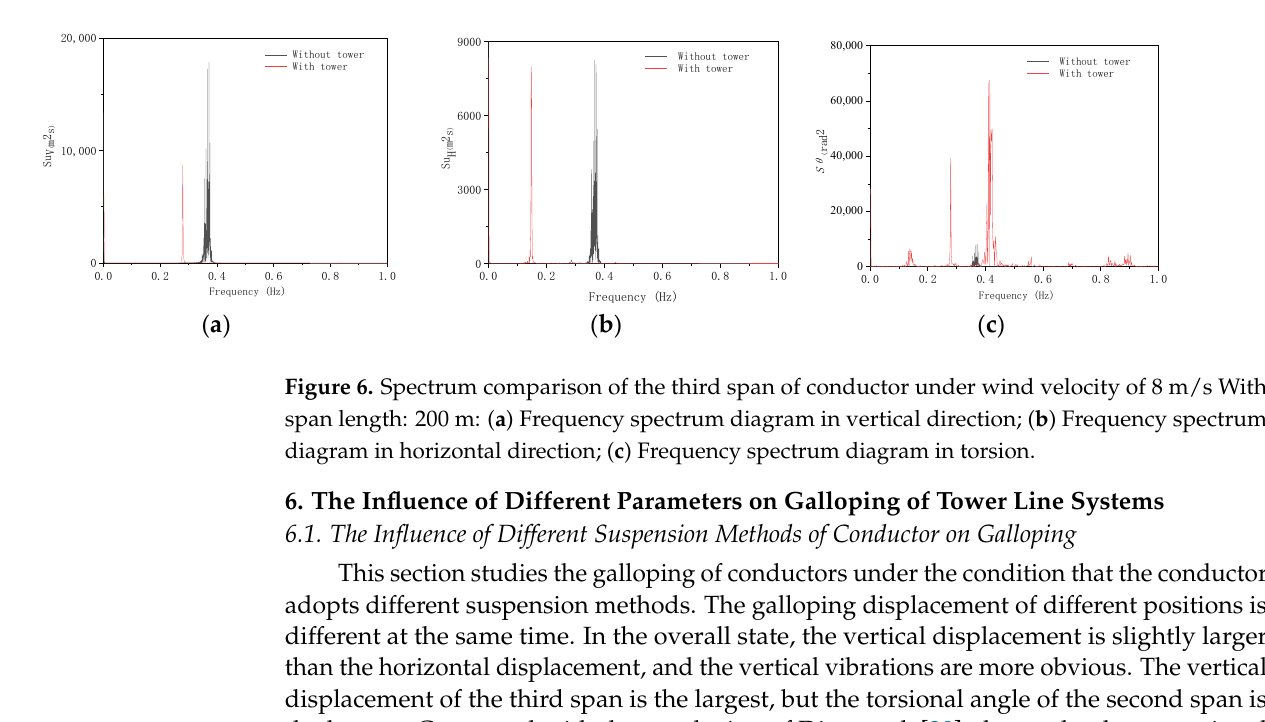
Figure 5. Midpoint spectrum diagram of each span of conductor under wind velocity of 8 m/s with span length: 400 m: ( a ) Spectrum diagram of the first span conductor; ( b ) Spectrum diagram of the second span conductor; ( c ) Spectrum diagram of the third span conductor.